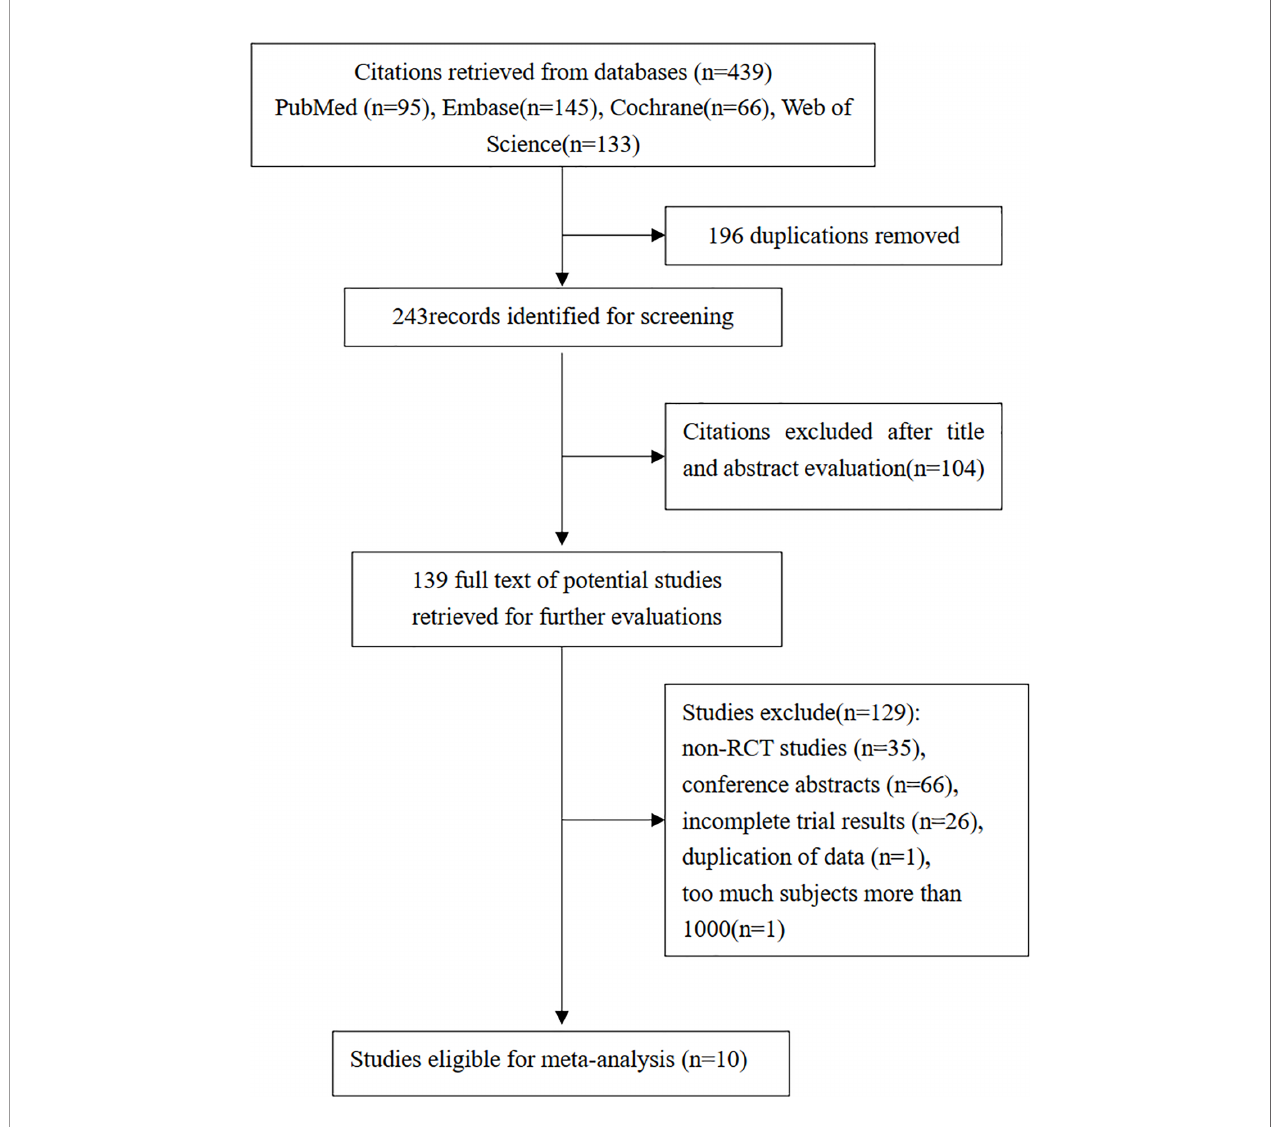
FIGURE 1 | Summary of study identi fi cation, inclusion, and